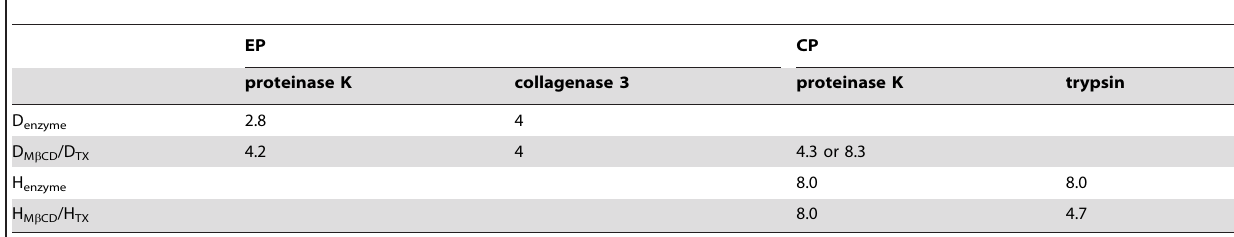
Table 1. Membrane height after treatment with enzyme and